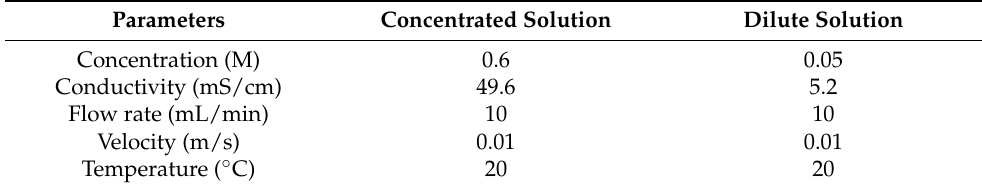
Table 2. Characteristics of saline